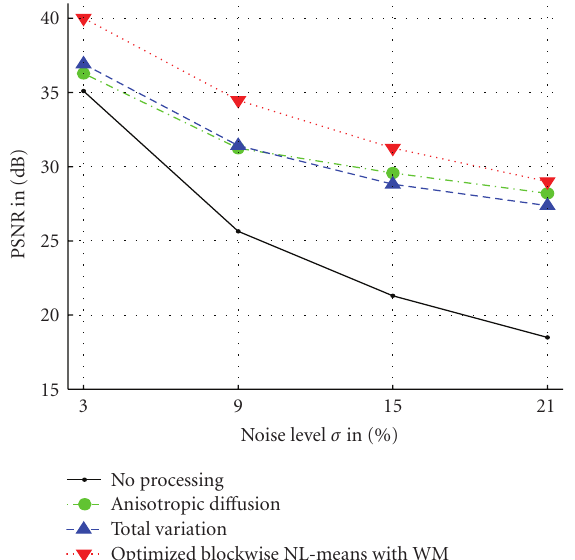
Figure 9: Comparison between nonlinear di ff usion, total varia- tion, and optimized blockwise NL-means with wavelet mixing denois- ing. The PSNR experiments show that the optimized blockwise NL- means with wavelet mixing filter significantly outperforms the well- established total variation minimization B 5 process and the nonlin- ear di ff usion approach.